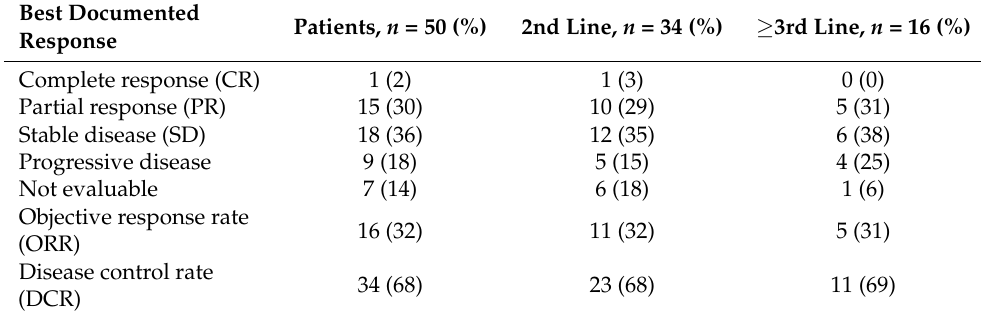
Table 2. Response